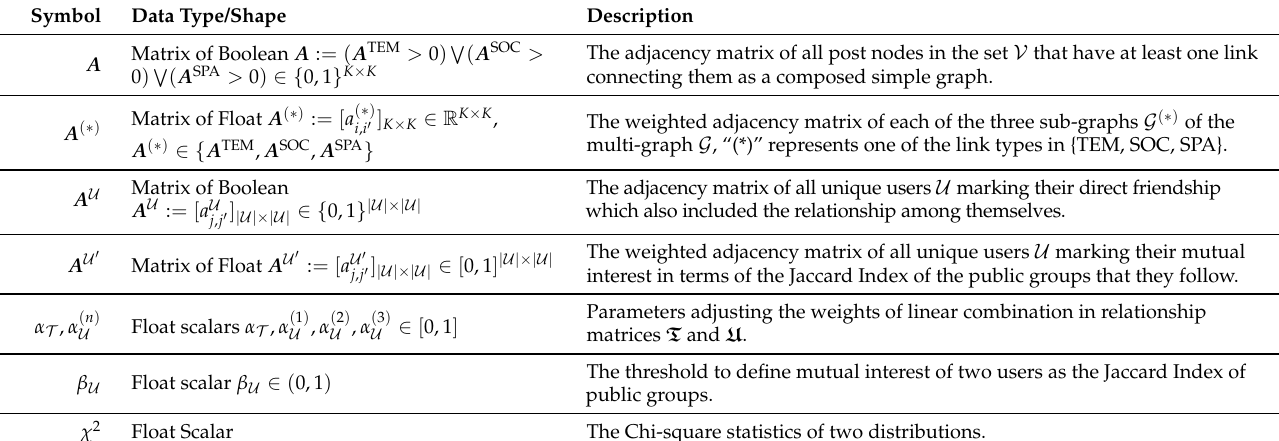
Table A1. The nomenclature of mathematical notations used in this paper in alphabetic order. All superscripts of matrices are merely tags, not to be confused with exponents and operations, with the exception of transpose operator (cid:3) T